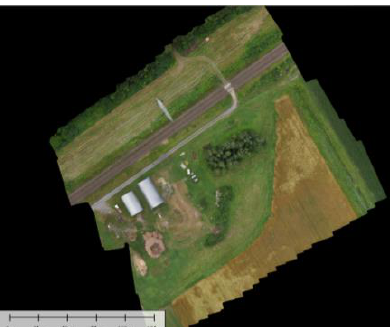
Figure 8: Orthophotos Displayed in Global Mapper software